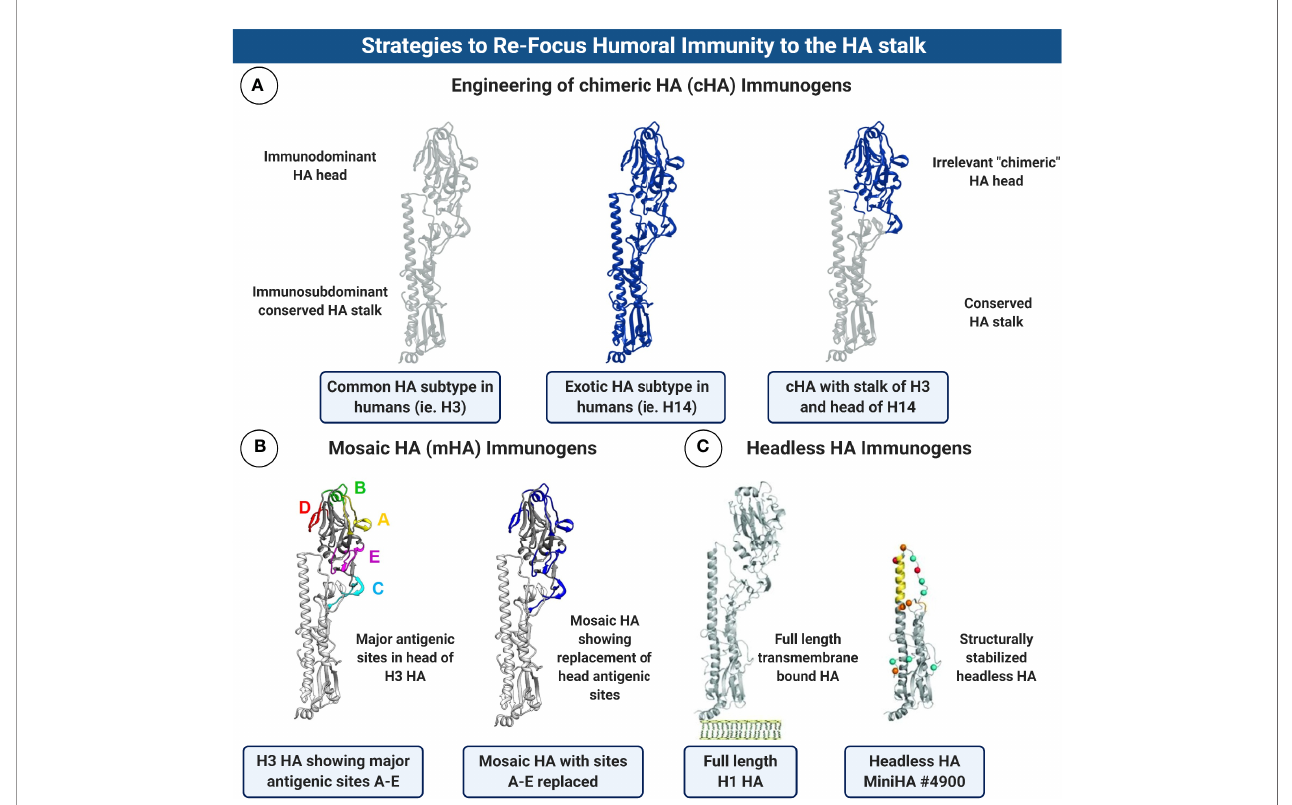
FIGURE 5 | Strategies to Re-focus Humoral Immunity to the HA stalk. (A) Schematic diagram showing the substitution of the HA head domain to make chimeric HA (cHA) immunogens. The concept behind this approach is to graft an exotic HA head, for which humans have no prior immunity, to the stalk of a HA subtype which is common in humans (ie. H1 or H3). Sequential immunization with cHA immunogens in which the exotic head is swapped with each boost can re-focus humoral immunity to the conserved HA stalk. Note: Structures are schematic and do not represent authentic junctions for substitution of the HA head region. (B) Mosaic HA (mHA) design is conceptually similar to cHAs but only the major antigenic sites in the HA head domain are swapped for comparable regions in an exotic HA. This can be used as an alternative approach to re-focus antibodies towards the HA stalk domain, with the added bene fi t of retaining possible conserved epitopes in the HA head. mHA structures kindly provided by Dr. Felix Broecker and Prof. Peter Palese, ISMMS. (C) Structurally stabilized headless HAs have been engineered which completely lack the immunodominant HA head domain, allowing boosting of immune responses towards the stalk only. HA structures in (C) are reproduced with permission from Impagliazzo et al. (147). Reprinted with permission from AAAS (License 4907650635299). Figure created with © BioRender -